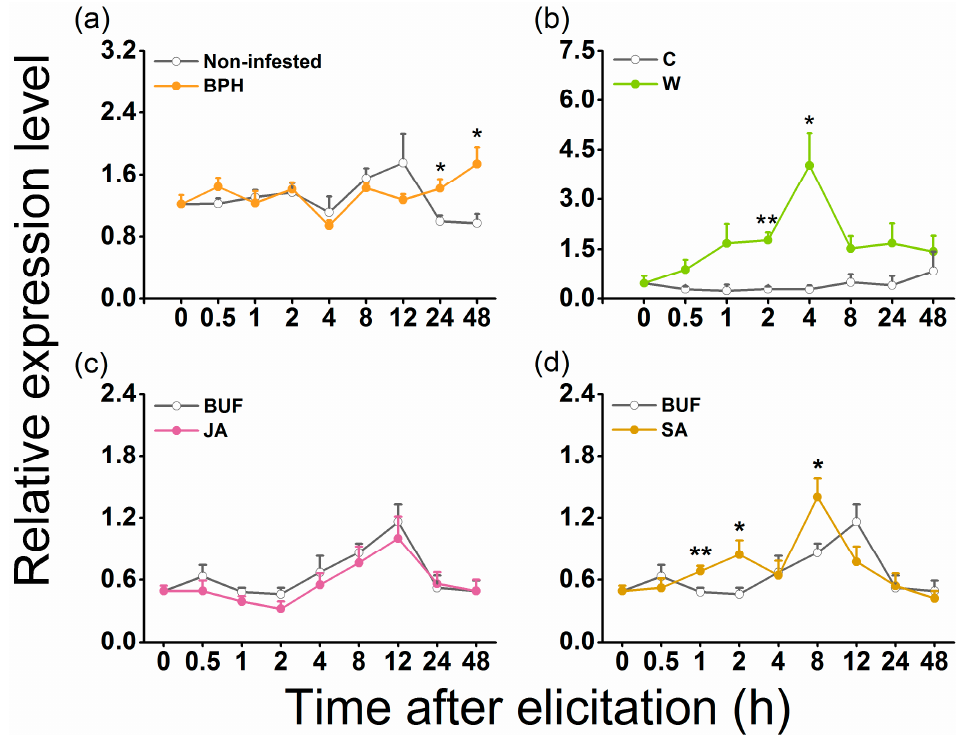
Figure 1. Quantitative real-time PCR (qRT-PCR) analysis of OsGID1 transcript levels in rice after different treatments. Relative levels (means + SE, n = 5) of OsGID1 transcripts in rice plants that were infested by gravid brown planthopper (BPH) females ( a ) or treated with mechanically wounding ( b ), jasmonic acid (JA) ( c ) or salicylic acid (SA) ( d ). Asterisks indicate